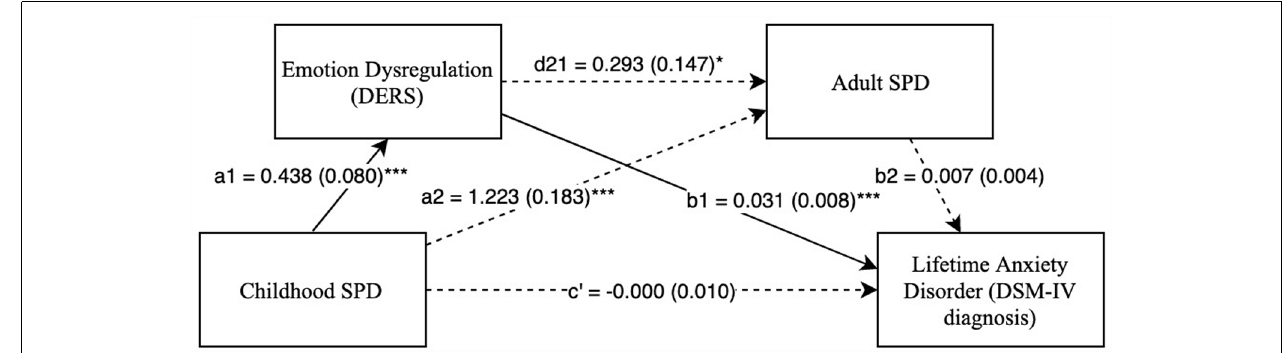
FIGURE 1 | Childhood SPD predicting lifetime anxiety with emotional dysregulation as mediator 1 and adult SPD as mediator 2. Note: ∗ p < 0.05, ∗∗∗ p < 0.001. Standard errors are in parentheses, solid lines represent significant indirect paths, a1 = unstandardized regression coefficient for the IV predicting the mediator 1, a2 = unstandardized coefficient for the IV predicting mediator 2 with mediator 1 in the model, d21 = unstandardized regression coefficient for mediator 1 predicting mediator 2 with IV in the model, b1 = unstandardized regression coefficient for mediator 1 predicting the DV with IV and mediator 1 in the model, b2 = unstandardized regression coefficient for mediator 2 predicting the DV with mediator 1 and the IV in the model, c (cid:48) = unstandardized coefficient for the IV predicting the DV with both the mediators in the model (indirect effect). SPD, Sensory Processing Disorder symptoms; DERS, Total score on Difticulty in Emotion Regulation Scale; SPDI, Sensory Processing Disorder Interview, version 2. Sex and race are included as covariates in all regression equations, coefficients of covariates are omitted for clarity.